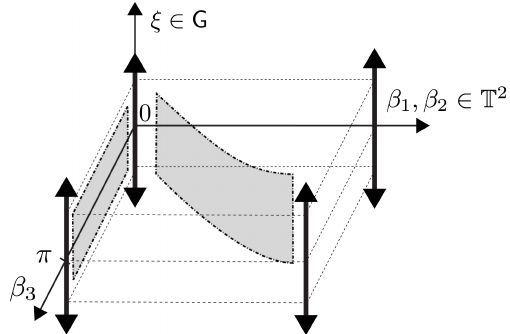
Figure 8. For three sliding constraints, the involutive closure of the coannihilator of the generalized codistribution D foliates Q into several leaves